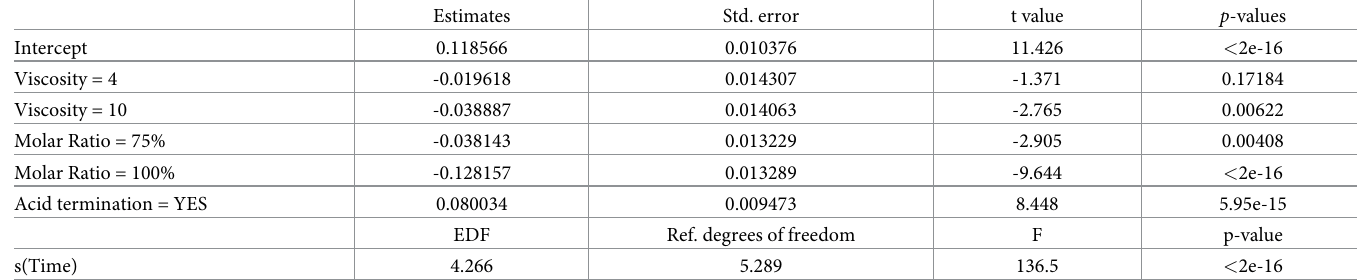
Table 5. GAM estimates and signification study corresponding to the modelling of mass loss vs time (quantitative), acid termination (factor), DL-lactide molar ratio (factor), and viscosity (factor). The measure of goodnes of fit is R 2 = 0.8.